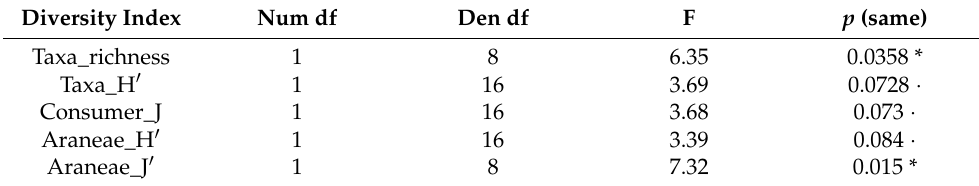
Table 2. Differences in diversity metrics values between unbuffered and forested buffered sites (One- way ANOVA). H (cid:48) = Shannon diversity index; J’ = Pielou’s evenness. Only statistically significant indices are